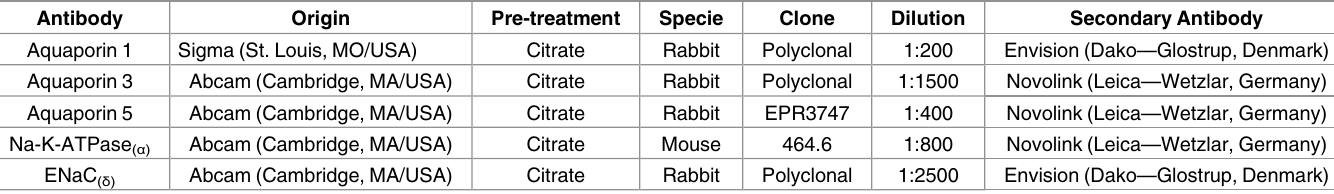
Table 1. Antibodies and processing used in immunohistochemical